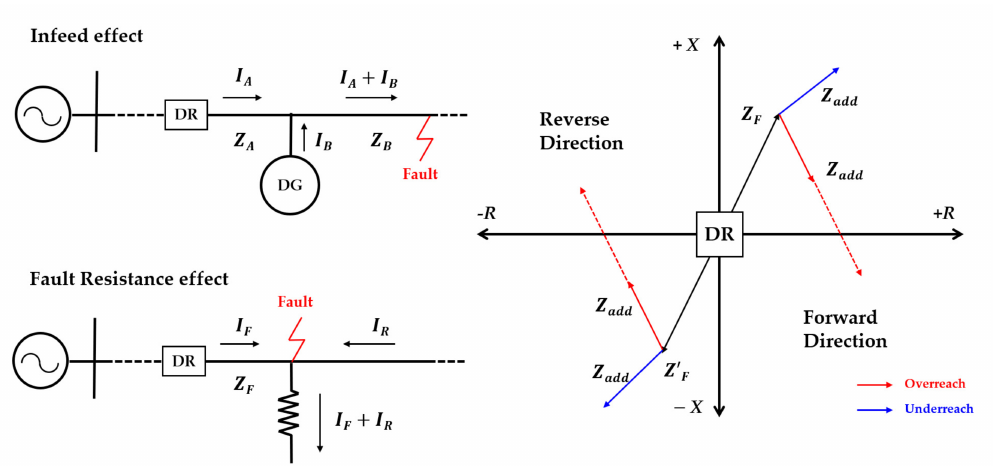
Figure 5. Limit of the distance